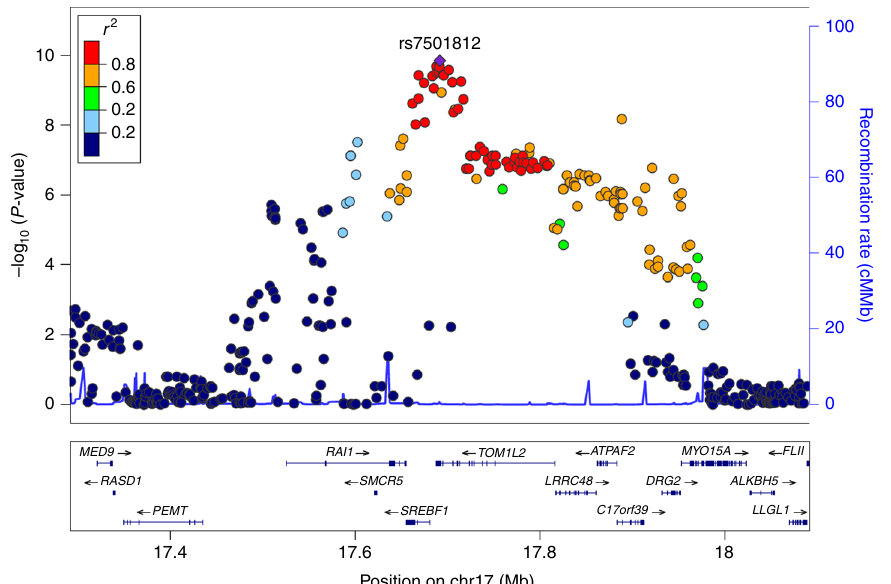
Fig. 2 Regional association plot for the bivariate meta-analysis of TBLH-BMD and TB-LM displaying the 17p11.2 locus. Genetic coordinates are as per Hapmap phase